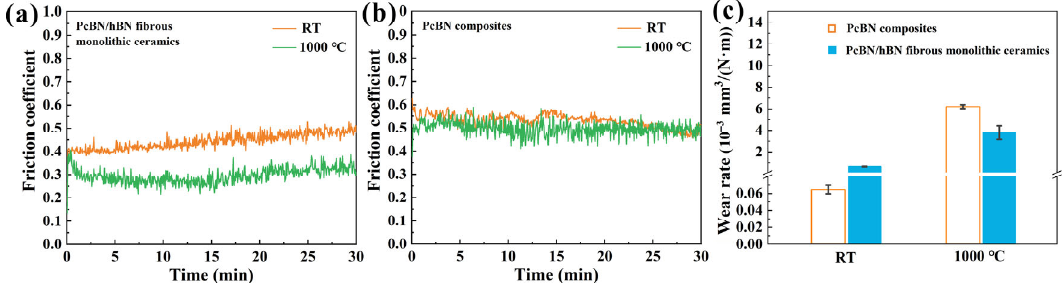
Fig. 6 (a, b) Typical friction coefficient curves and (c) wear rates of PcBN/hBN fibrous monolithic ceramics and homogenous PcBN composites at RT and 1000 ℃